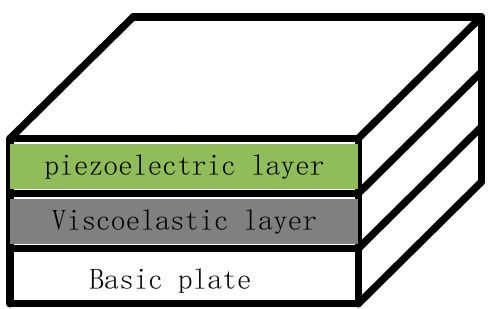
Figure 2. The structure of ACLD treatment.